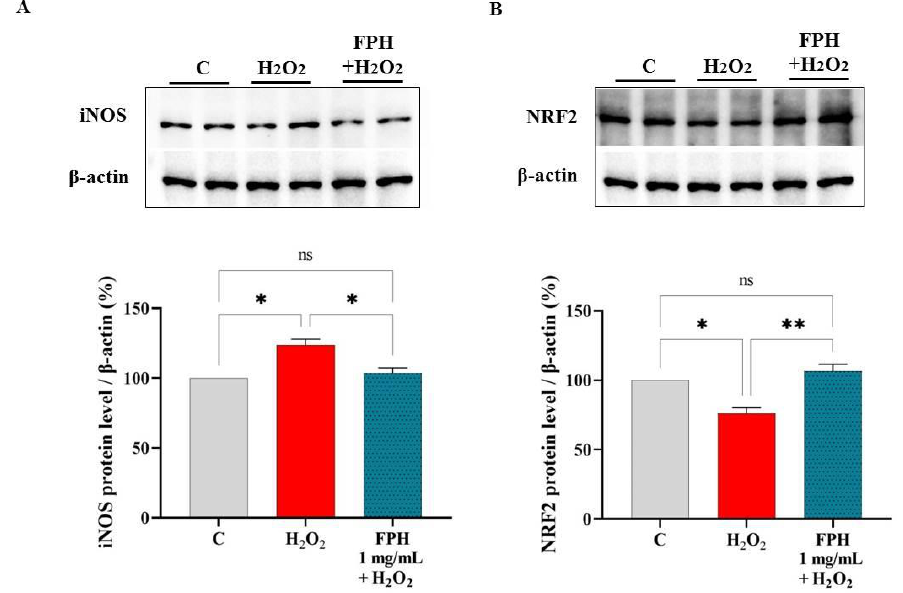
Figure 5. Effect of FPH on the H 2 O 2 (1 mM)-induced iNOS ( A ) and NRF2 ( B ) protein levels in human intestinal Caco-2 cells. The data points represent the averages ± s.d. of three independent experiments in duplicate. All data sets were analyzed by one-way ANOVA followed by Tukey’s post-hoc test. C: control sample; ns: not significant; (*) p < 0.05, (**) p < 0.01.